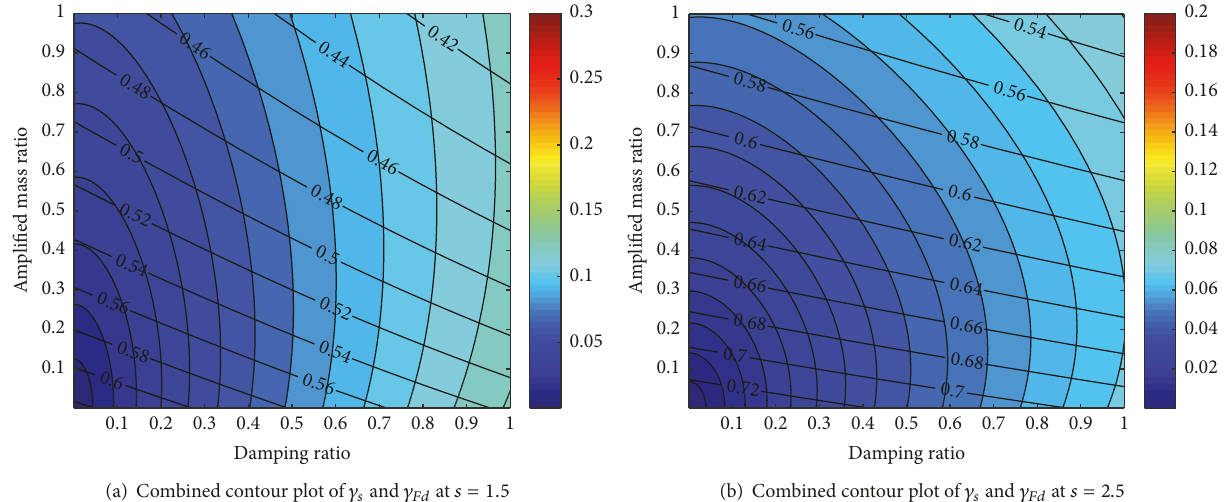
(a) Combined contour plot of 𝛾 𝑠 and 𝛾 𝐹𝑑 at 𝑠 = 1.5 (b) Combined contour plot of 𝛾 𝑠 and 𝛾 𝐹𝑑 at 𝑠 = 2.5 Figure 4: Combined contour plots of 𝛾 𝑠 and 𝛾 𝐹𝑑 (the color-filled contour represents the values of 𝛾 𝐹𝑑 , while the solid lines in the plane represent the values of 𝛾 𝑠 ).